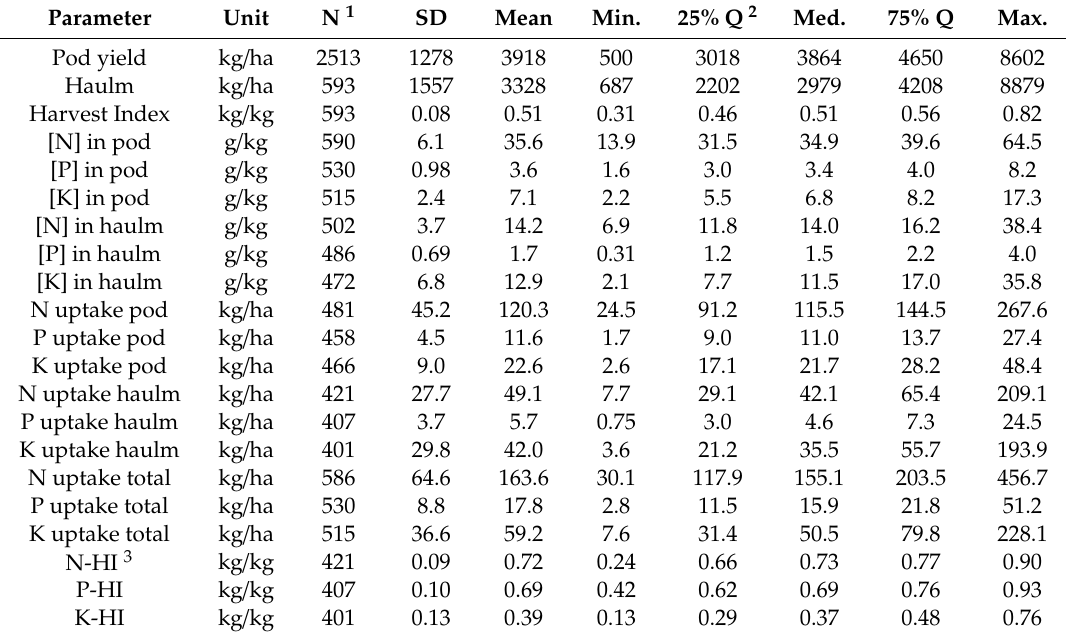
Table 1. Characteristic statistics of the pod yields (10.0% moisture content) and nutrient uptake data at maturity for China’s peanut crops.